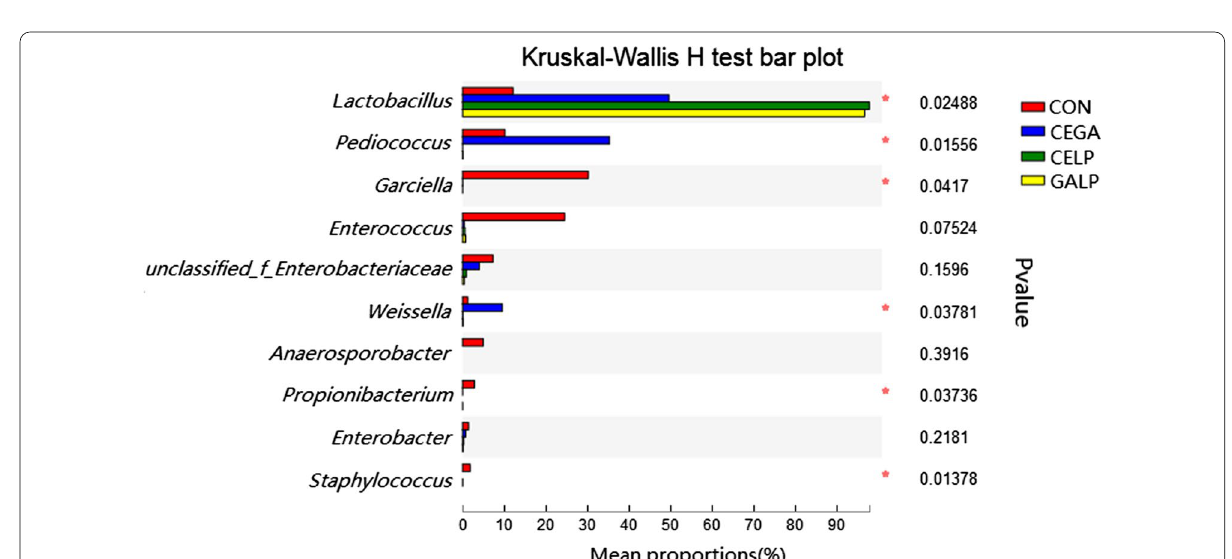
Fig. 3 Kruskal–Wallis H test of the bacterial community at the genus level. The top 10 genera are shown in the figure. CON untreated silage, CEGA cellulase plus ɑ -galactosidase, CELP cellulase plus L. plantarum , GALP ɑ -galactosidase plus L.